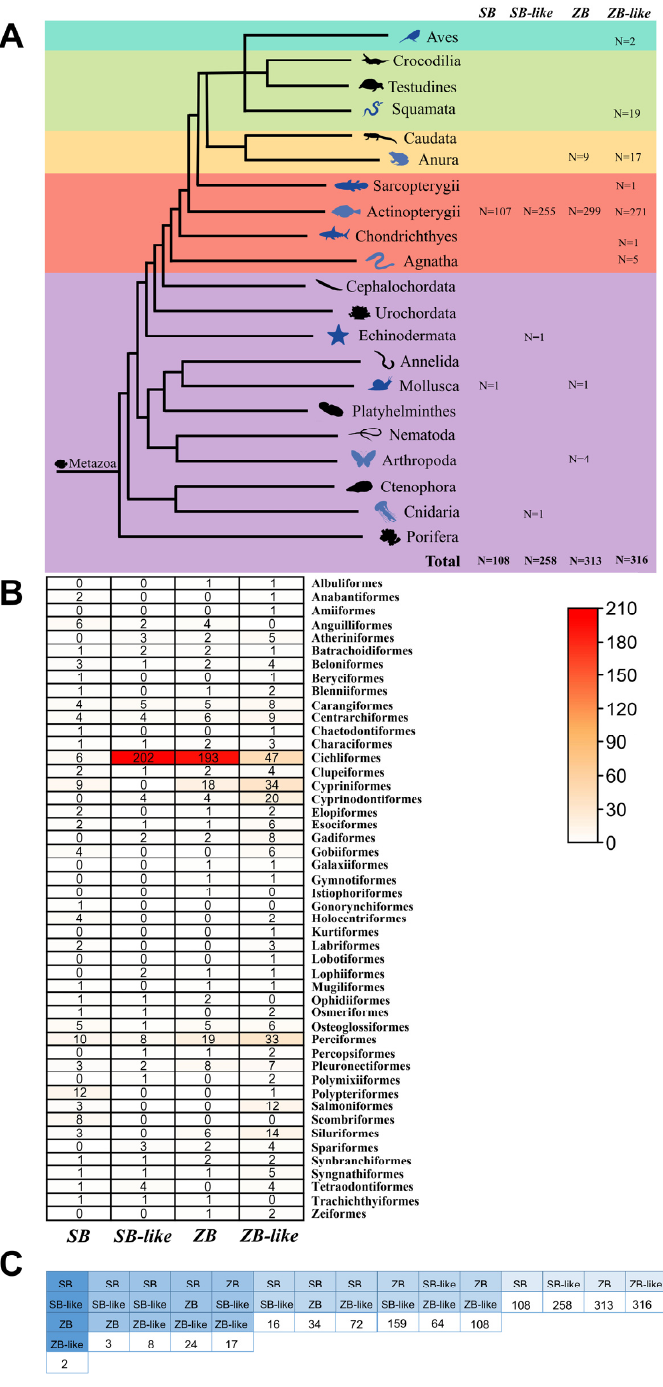
Figure 3. Taxonomic distribution of SB and ZB elements. ( A ) Taxonomic distribution of SB and ZB elements in the Metazoa, including cluster SB , cluster SB -like, cluster ZB, and cluster ZB -like. The numbers following the animal panels represent the number of species for which the corresponding transposon was detected in that lineage. ( B ) Taxonomic distribution of SB and ZB elements in the Actinopterygii. This graph was drawn based on statistics (Supplementary Table S3). The numbers in the table represent the distribution of SB and ZB species in this order. The darker the color, the more species containing the corresponding transposon in that order. ( C ) Overlapping species of SB and ZB . The numbers in the figure represent the number of species that possess several types of transposons in this